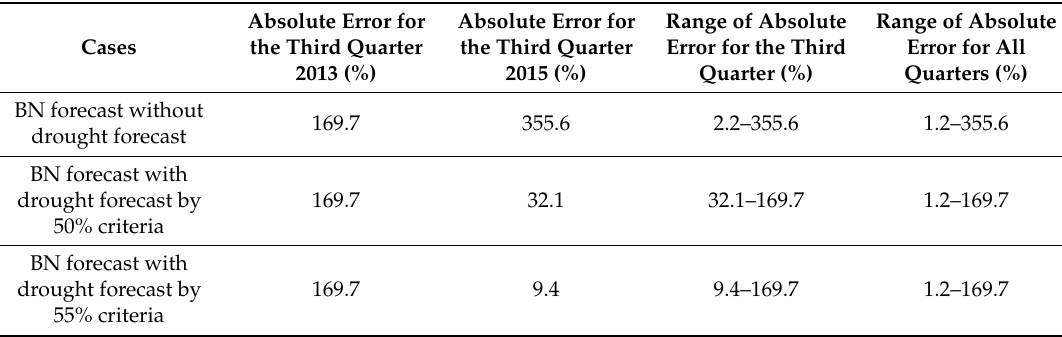
Table 6. Quarterly inflow forecasting errors for the Andong